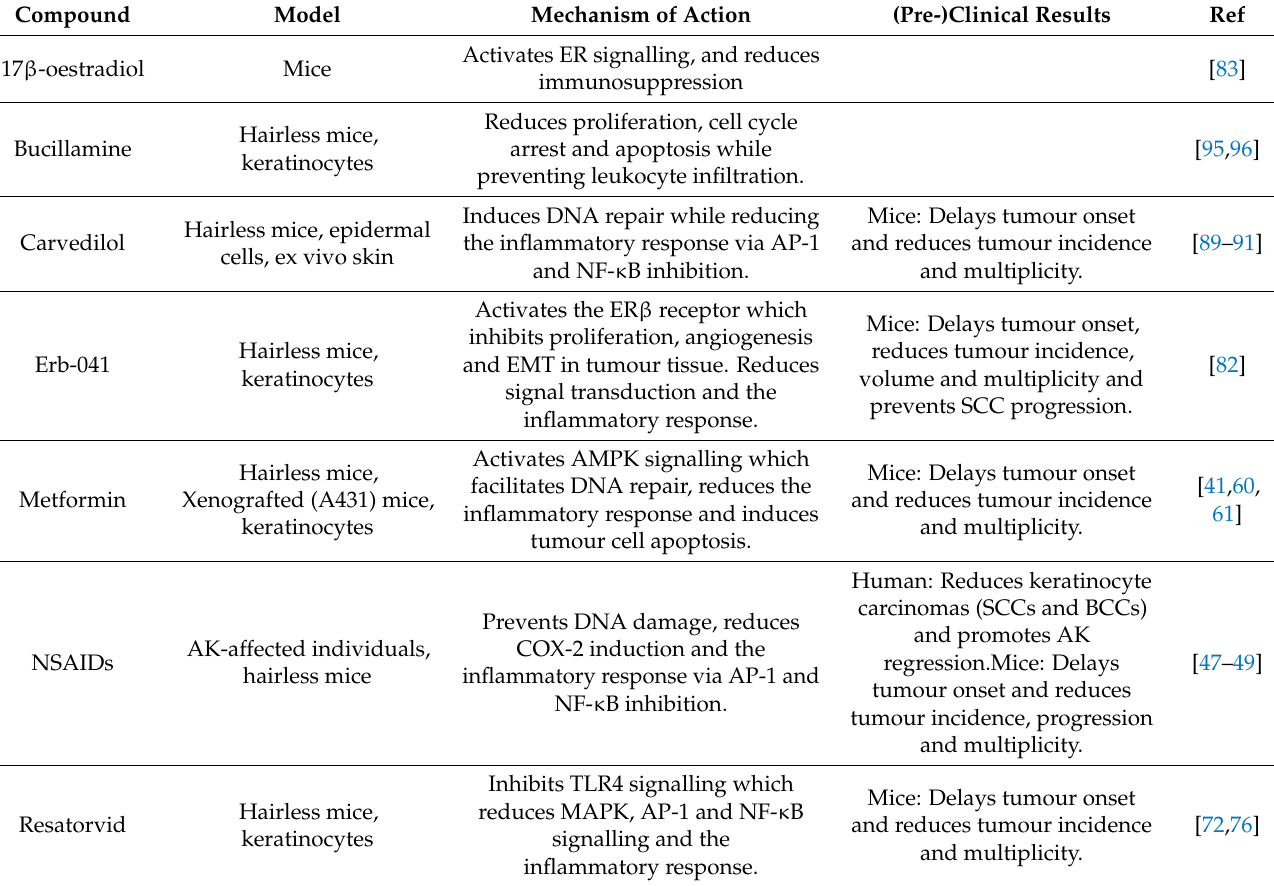
Table 2. Selected pharmaceuticals that have been tested for photoprotective effects, their proposed mechanisms and, if applicable, (pre-)clinical